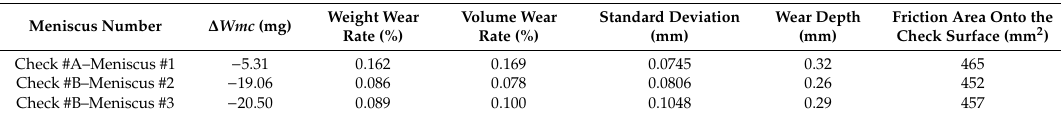
Table 2. Wear results.